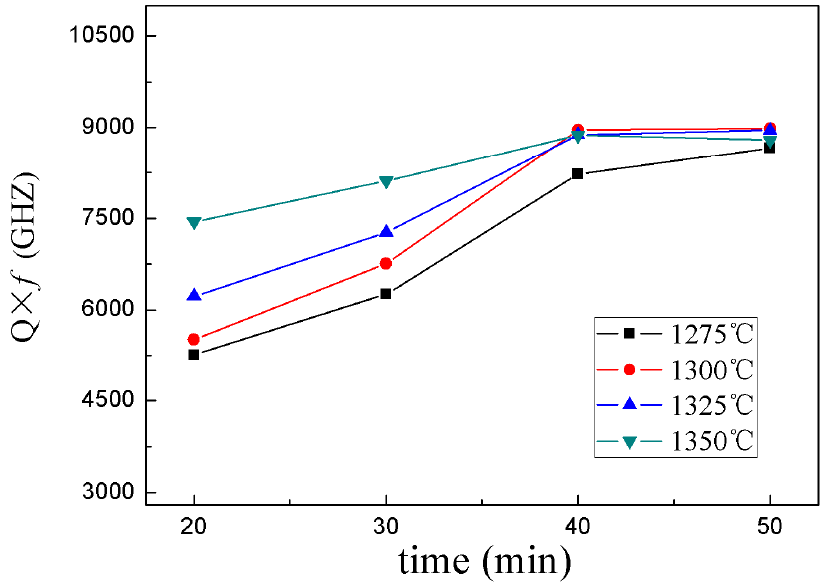
holding times by Figure 5. Q × f value of the 0.95CST–0.05BNT samples with different sintering temperatures and holding times by MWS.